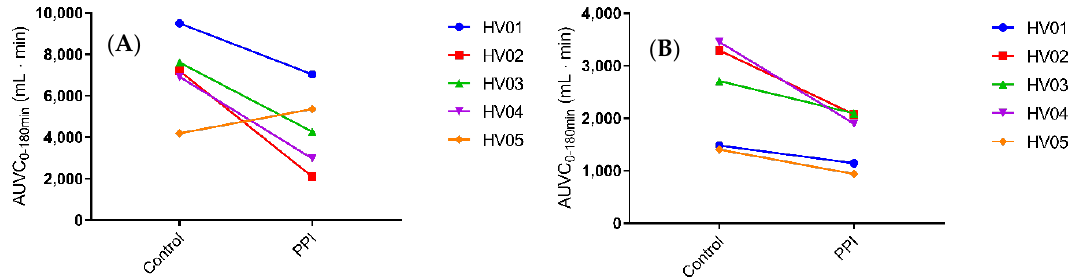
Figure 8. Total individual ( A ) gastric fluid volume and ( B ) duodenal fluid volume in five healthy volunteers (HV) following oral intake of a Norvir tablet in control condition vs. PPI condition, expressed as the area under the volume curve (AUVC) during the first 180 min.